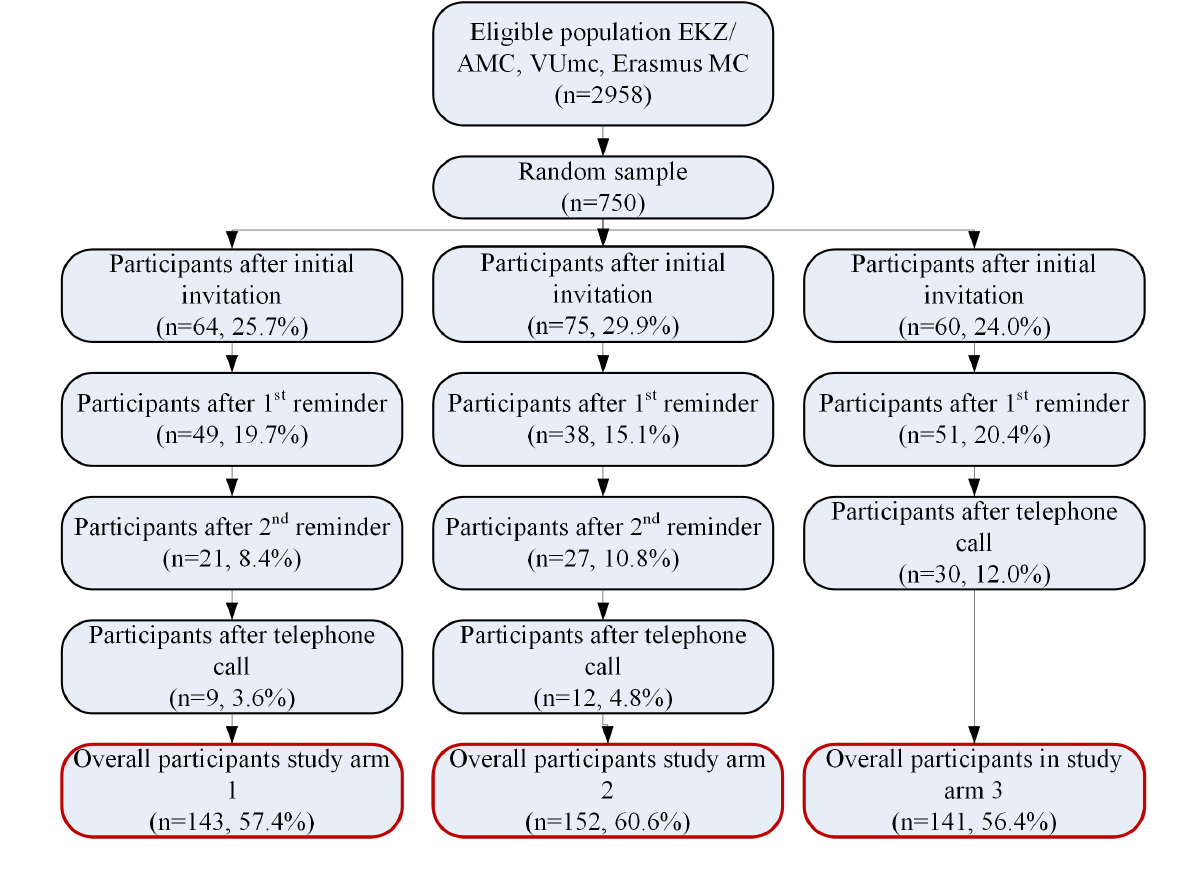
Figure 1. Flow diagram of the study.